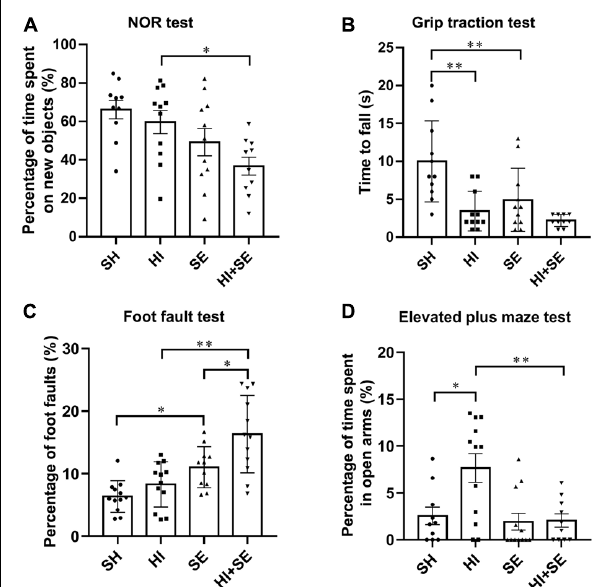
FIGURE 1 | Behavioral test results at P40–44. Novel object recognition (NOR) test (A) , grip traction test (B) , foot fault test (C) , and elevated plus maze test (D) in female offspring at P40–44 ( n = 10). Results are expressed as mean ± SEM. ∗ P < 0.05, ∗∗ P < 0.01, analyzed by two-way ANOVA followed by post hoc Turkey tests. SH, from sham exposed dams with sham surgery; HI, hypoxic-ischemic injury; SE, from smoke exposed dams with sham surgery; HI + SE, from smoke exposed dams with hypoxic-ischemic